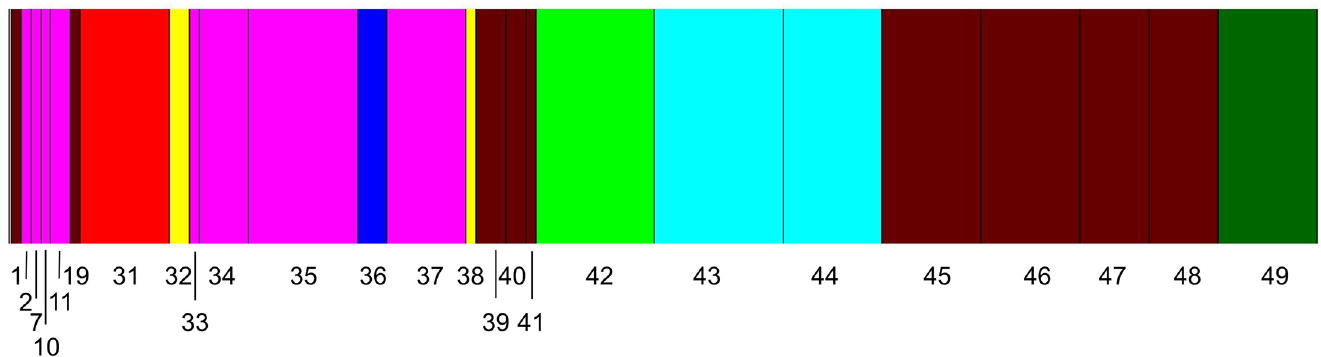
Fig 3. Genetic clustering of samples using the Bayesian method implemented in the program BAPS. The numbers refer to the sample numbers. The width of each band is proportional to the number of individuals in each sample. Samples collected at a hotel (sample 31) and homeless shelter (sample 32) are included in the